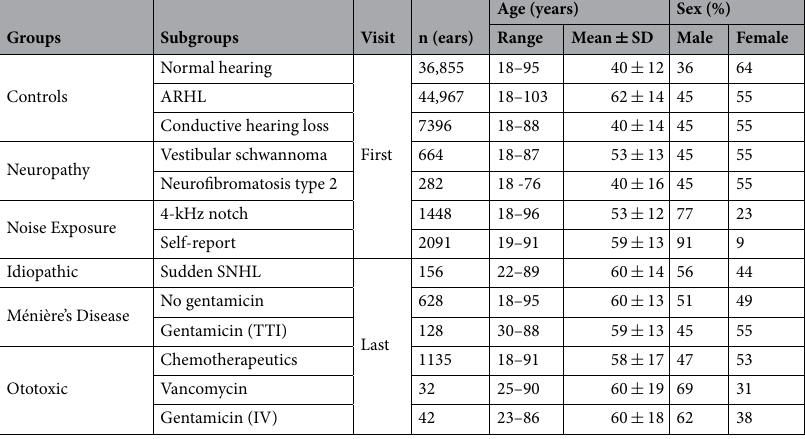
Table 1. Demographics of study